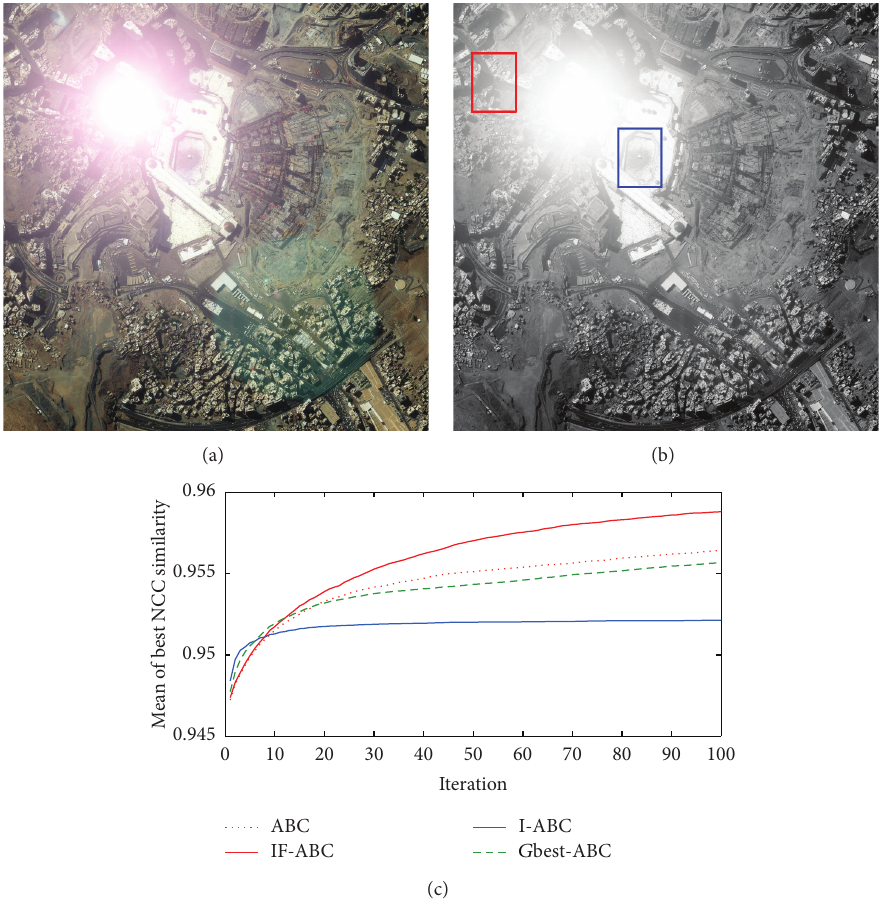
Figure 8: Practical template matching case 1. (a) Nonuniform illumination disturbed source image; (b) ground matching truth (blue box) and most common false matching result (red box); (c) comparative evolution curves of four ABC